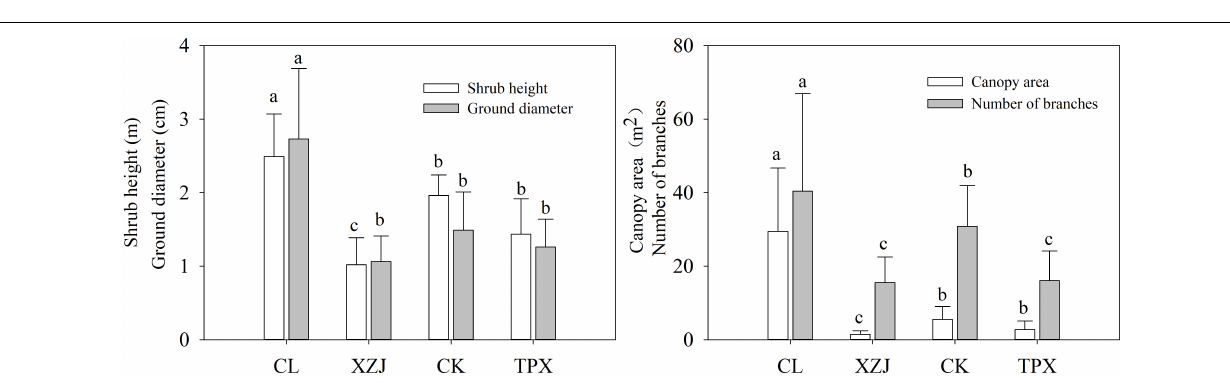
Frontiers in Plant Science |